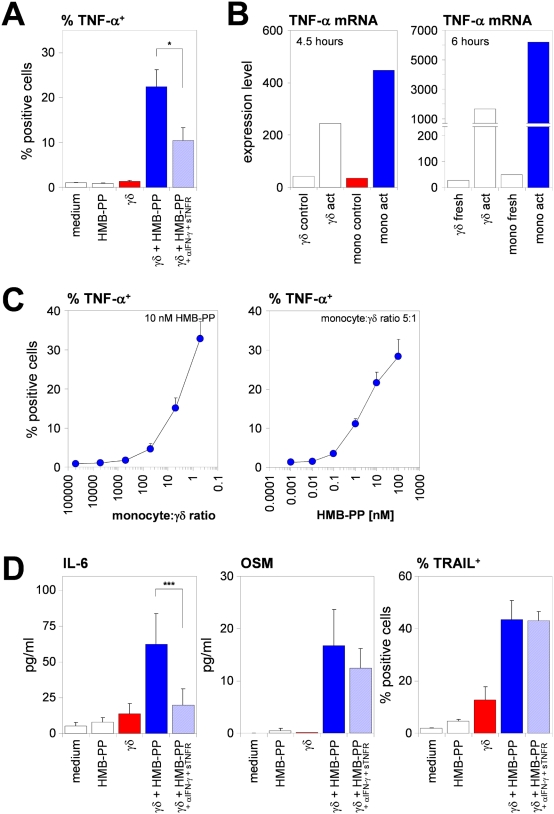
Vγ9/Vδ2 T cell-activated monocytes produce inflammatory mediators.(A) Mean percentages±SEM of TNF-α+ monocytes after 18 hours of culture under the conditions indicated (n = 3–7). (B) Mean mRNA expression levels of TNF-α from duplicate measurements for activated monocytes and γδ T cells sorted after 4.5–6 hours from co-cultures in the presence of HMB-PP, compared with control cells sorted from co-cultures in the absence of HMB-PP (left), or with freshly isolated, resting monocytes and γδ T cells (right). (C) Mean percentages±SD of TNF-α+ monocytes co-cultured with γδ T cells at various ratios in the presence of 10 nM HMB-PP (left), or with γδ T cells at a ratio of 5∶1 in the presence of different concentrations of HMB-PP (right), as analyzed after 18 hours in triplicate cultures. (D) Mean protein levels (pg/ml)±SEM of secreted IL-6 and OSM, and mean percentages±SEM of TRAIL+ monocytes after 18 hours of culture under the conditions indicated (n = 3–7).